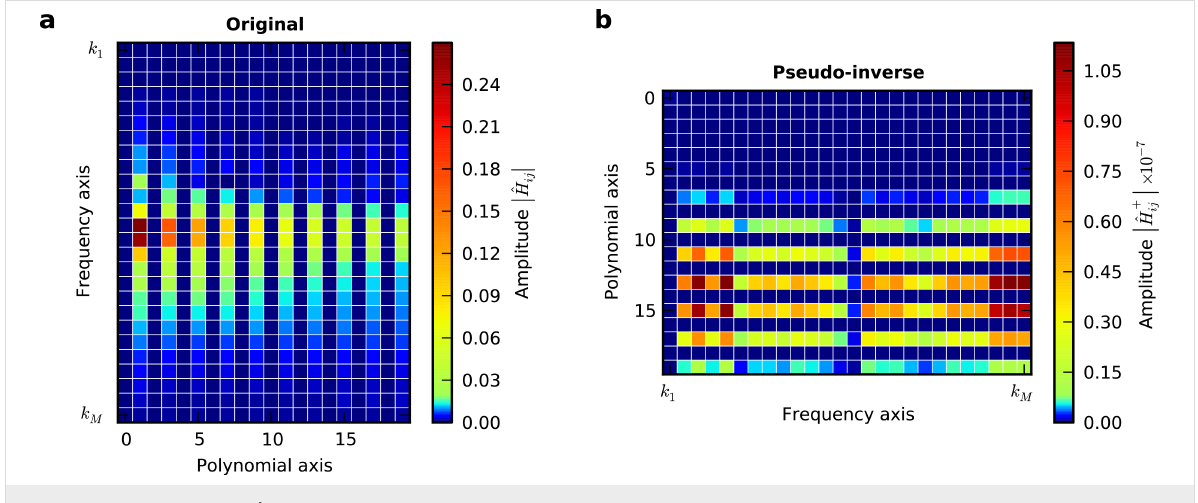
Figure 1: Visualization of the matrix (a) and its pseudo-inverse (b). Only rows with non-zero elements are displayed.